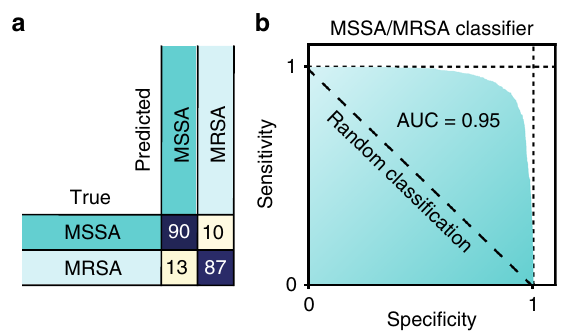
Fig. 3 Binary MRSA/MSSA classi fi er. a A binary classi fi er is used to distinguish between methicillin-resistant and -susceptible S. aureus (MRSA/MSSA), achieving 89.1±0.1% accuracy. b By varying the classi fi cation threshold, it is possible to trade off between sensitivity (true positive rate) and speci fi city (true negative rate). The ROC curve